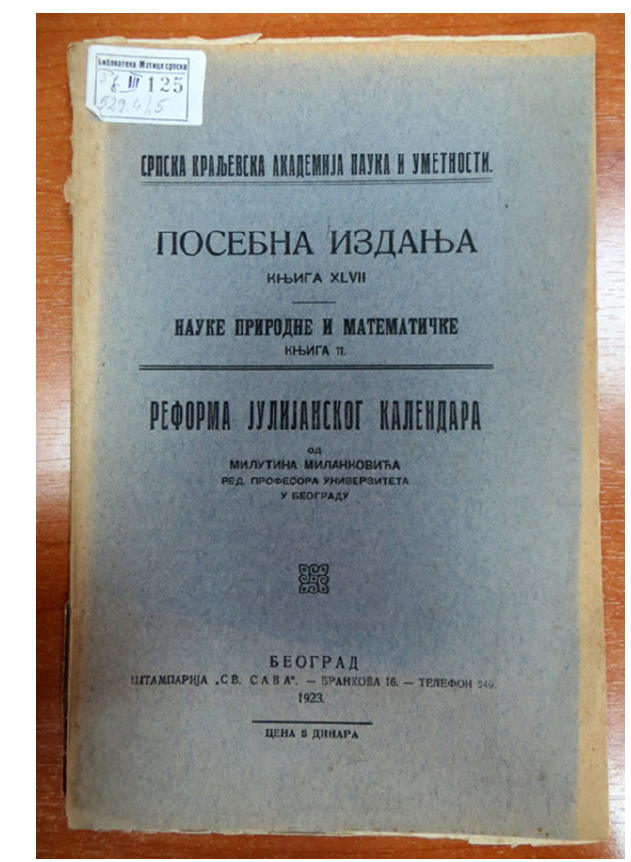
Figure 4. Milankovitch’s original Reform of the Julian Calendar , published in 1923.